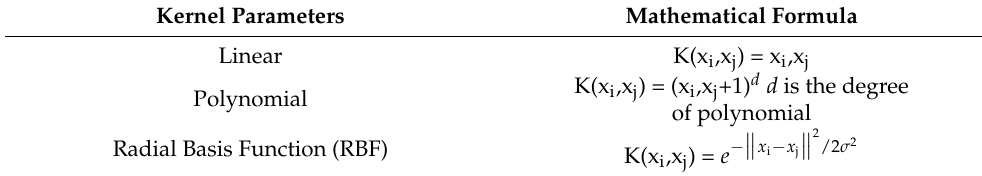
Table 2. List of kernel functions used in